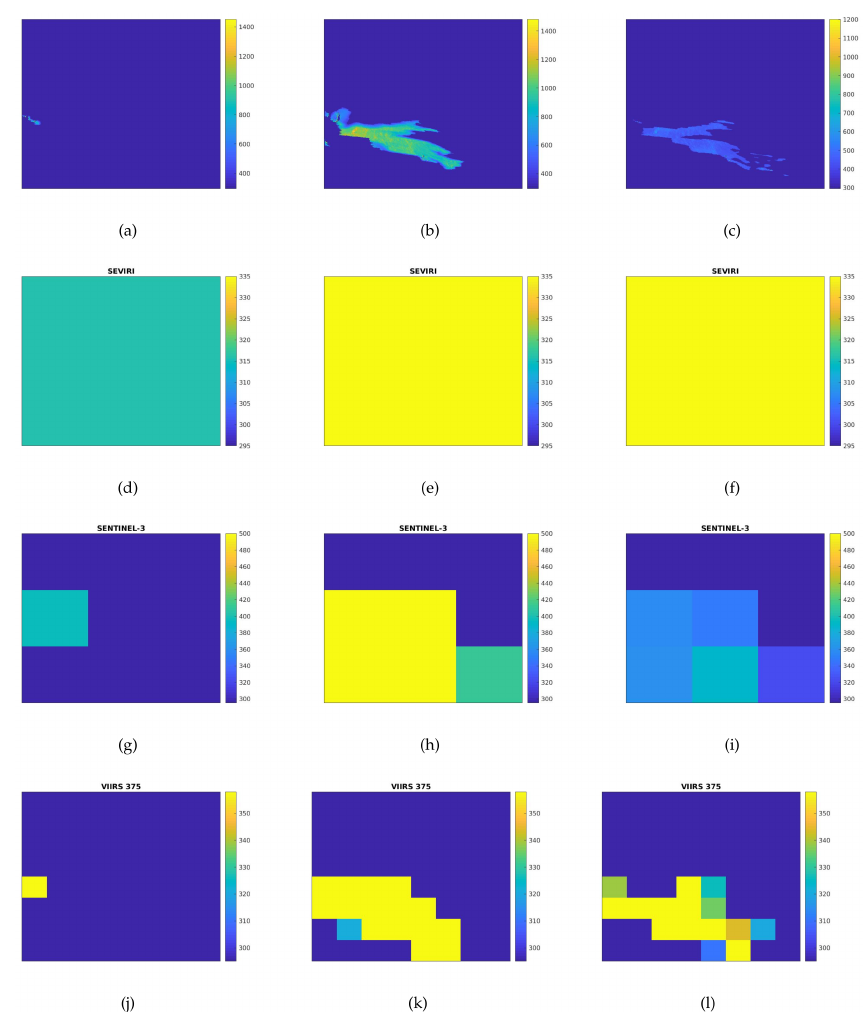
Figure 2. Remote sensor response for each class-sensor for the lava flow emplacement at Mount Etna, Sicily on the 12 August 2011 for each remote sensor : ( d – f ), SEVIRI; ( g – i ) SENTINEL-3 SLSTR; ( j – l )